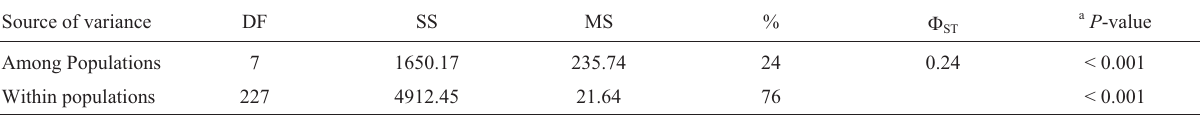
Table 4 - Analysis of molecular variance (AMOVA) within and among populations.